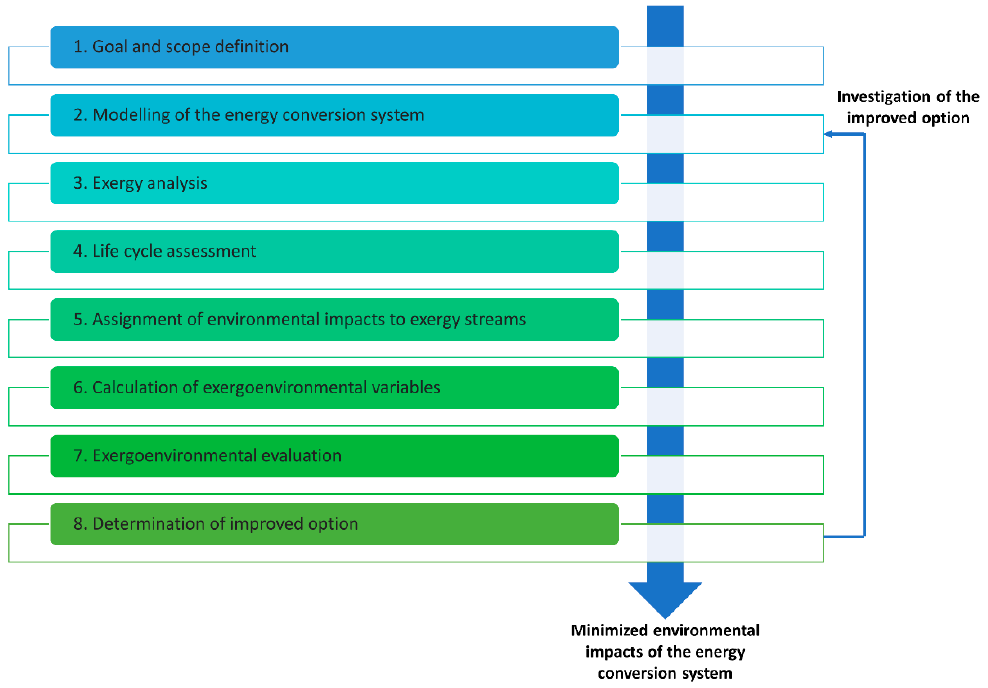
Figure 7. Flowchart of energy, exergy, exergoeconomic, and exergoenvironmental (4E) analysis.